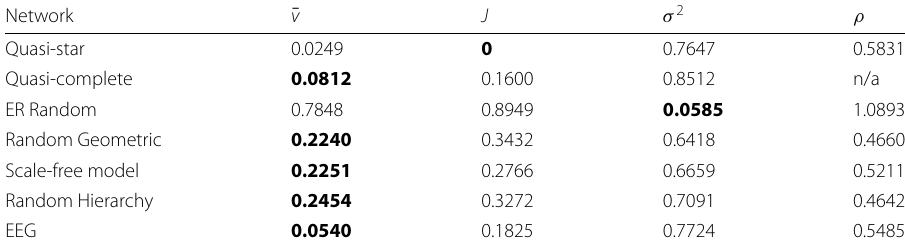
Table 3 Coefficient of variation of network indices with respect to network size, averaged over density Network ¯ v J σ 2 ρ Quasi-star 0.0249 0 0.7647 0.5831 Quasi-complete 0.0812 0.1600 0.8512 n/a ER Random 0.7848 0.8949 0.0585 1.0893 Random Geometric 0.2240 0.3432 0.6418 0.4660 Scale-free model 0.2251 0.2766 0.6659 0.5211 Random Hierarchy 0.2454 0.3272 0.7091 0.4642 EEG 0.0540 0.1825 0.7724 0.5485 Boldface indicates the best result among the